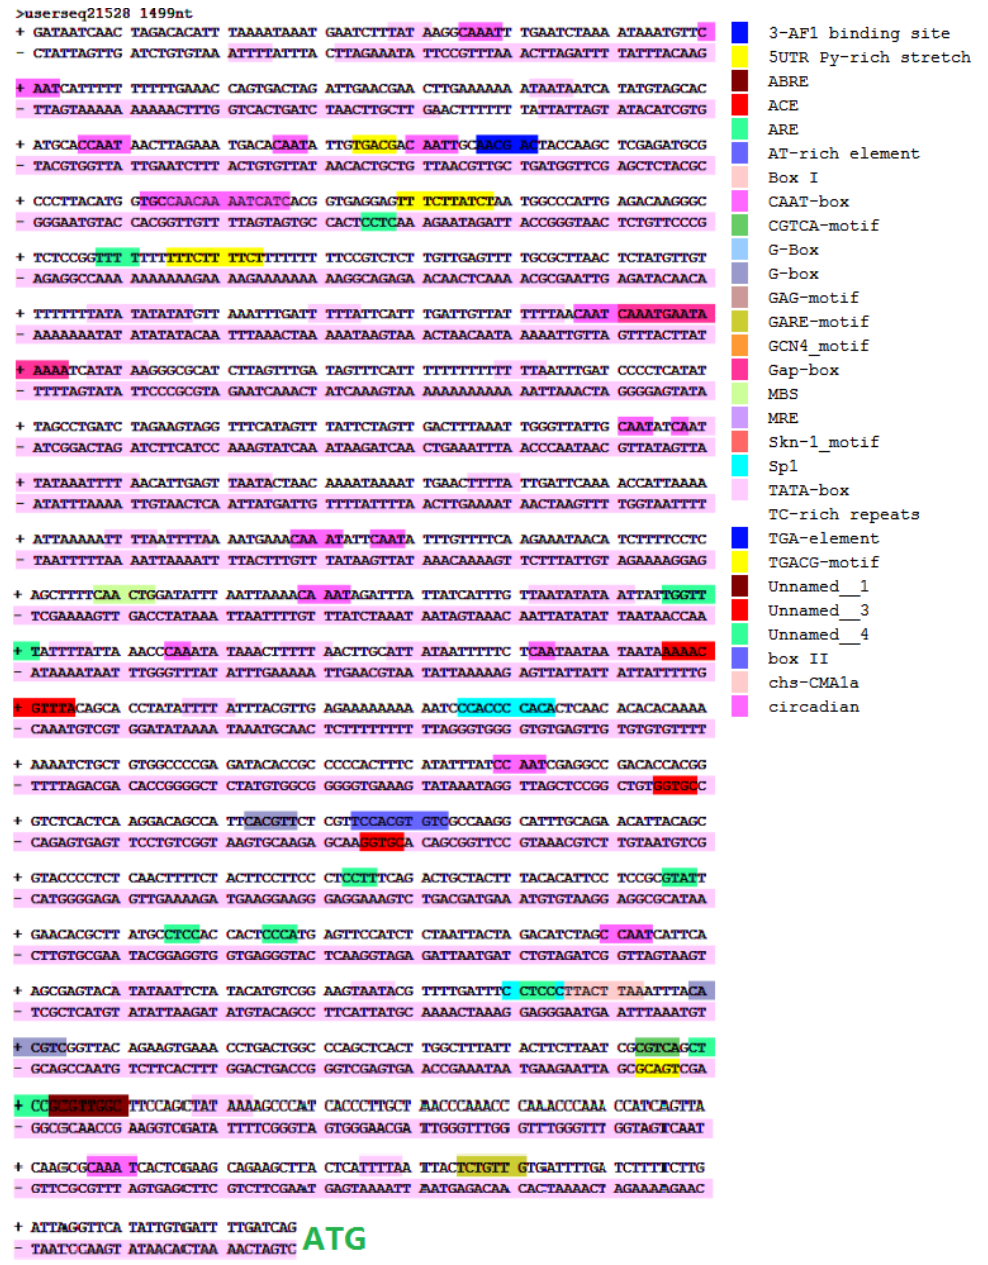
Figure 2. Nucleotide sequence of the PtrDHN-3 promoter (1500 bp). Abiotic stress-related cis-regulatory elements are boxed and labeled with colors.